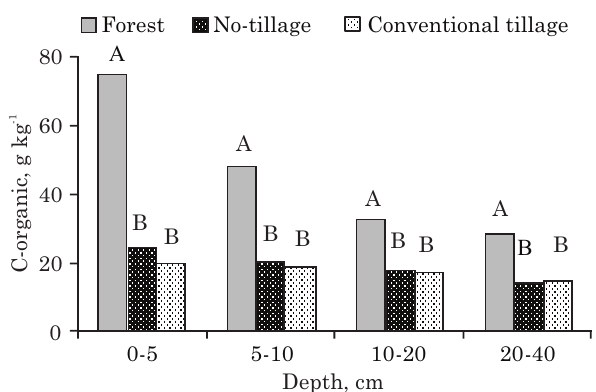
Figure 3. Total organic carbon (TOC) content as a function of management system and soil depth